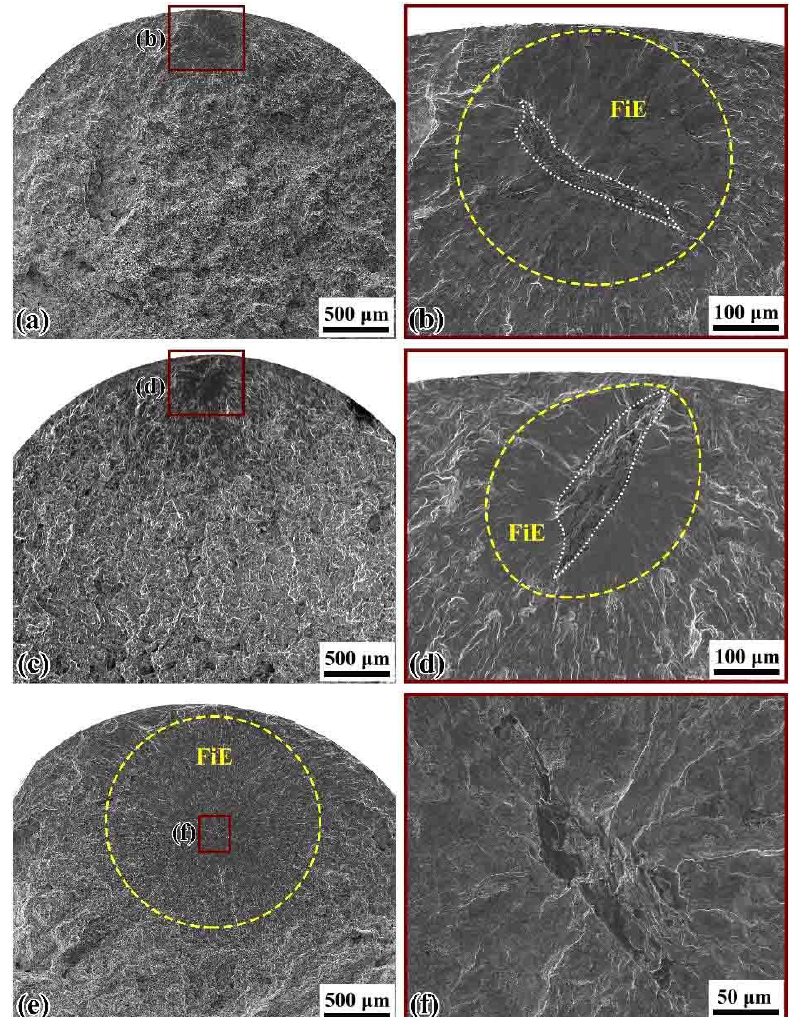
Figure 9. Typical fracture morphologies of internal crack initiation by ultrasonic fatigue test: ( a ) R = − 1, σ a = 262 MPa, N f = 7.78 × 10 6 cycles; ( c ) R = − 1, σ a = 258 MPa, N f = 1.01 × 10 7 cycles; ( e ) R = 0.3, σ a = 202 MPa, N f = 1.84 × 10 7 cycles; while magnified views of inclusions inducing